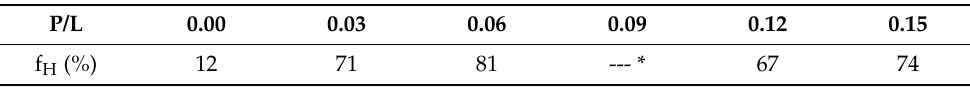
Table 1. Helicity (f H ) of W-BP100 in POPC:POPG (1:1) LUVs at increasing P/L ratios. Measurements